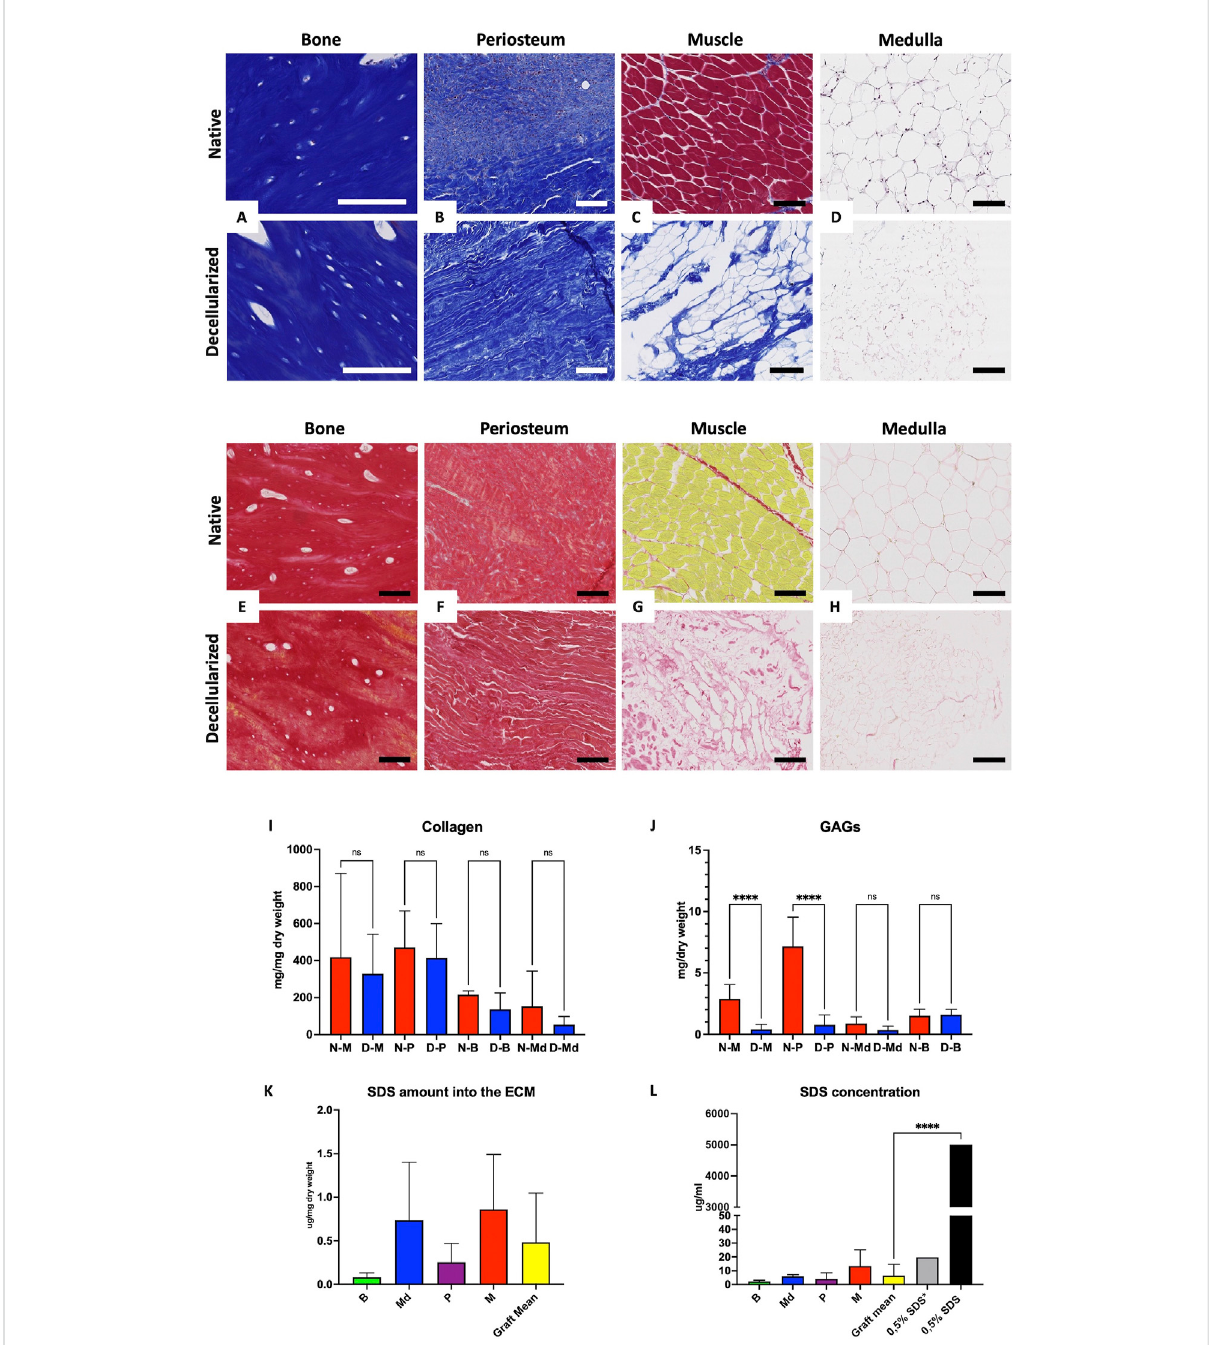
FIGURE 3 Preservation of the ECM and residual SDS quanti fi cation. A – D: Masson ’ s trichrome histological staining of native (top) and decellularized (bottom)corticalbone (A) ,periosteum (B) ,muscle (C), andmedulla (D) .Scalebarfor (A) =100 µmandB-C-D=200 µm. (E – H) :Siriusredhistological staining showing collagen fi bers, preservation of native (top) and decellularized (bottom) cortical bone (E) , periosteum (F) , muscle (G), and medulla (H) . All scale bars 100 µm. (I – J) : Collagen (I) and GAGs (J) quanti fi cation in native (N-, red) and decellularized (D-, blue) muscle (M), cortical bone (B), periosteum (P), and medulla (Md) (n = 5 each, mean values expressed in µg/mg dry weight ± SD; ns = non-signi fi cant, **** p < 0.0001). (K – L) : SDS residues into acellular ECM (K) and SDS concentration in digested tissues with 1 ml of proteinase K solution (L) in decellularized cortical bone (B), medulla (Md), periosteum (P), and muscle (M) in comparison with 0.5% SDS* (0.5% SDS diluted 250×) and theorical 0.5% SDS solution (n = 3 each, mean values expressed in µg/ml (K) and µg/mg (L) dry weight ± SD; **** p <